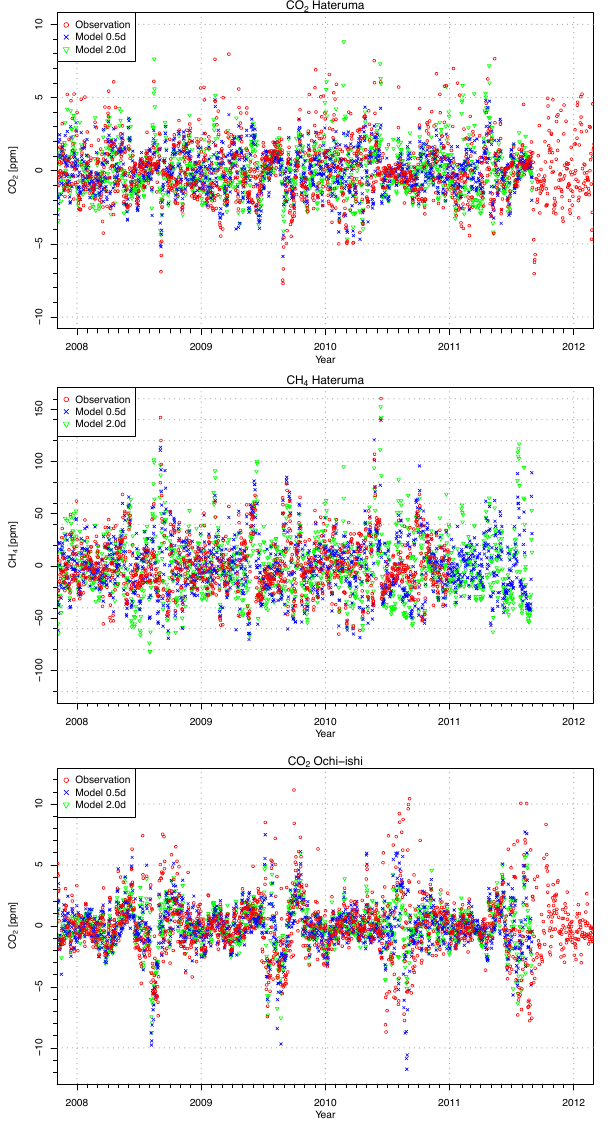
Fig. 7. Synoptic variations in observed and simulated time series of daily mean CO 2 and CH 4 concentrations at Hateruma site and CO 2 concentration at Ochi-ishi site. “0.5d” and “2.0d” in legends indi- cate 0.5-degree simulation and 2.0-degree simulation, respectively.